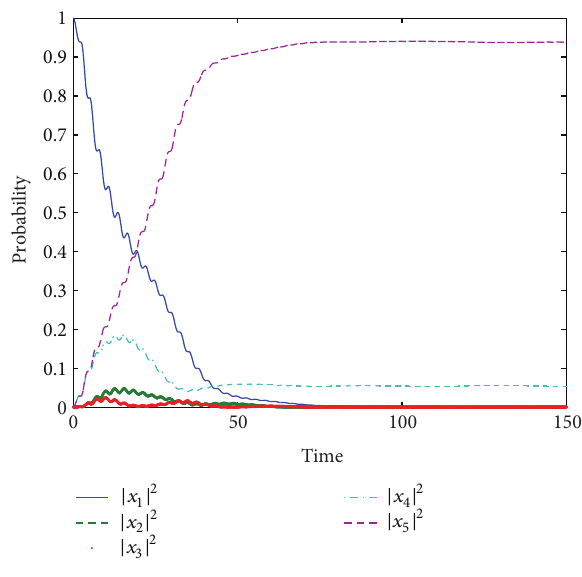
Figure 1: The population of the five-level system trajectory from ⟩ by control fields 𝑓 |𝜓 0